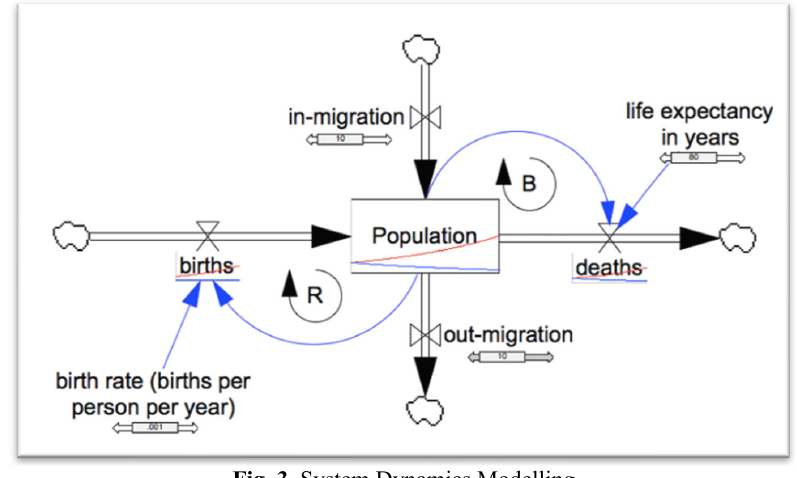
Fig. 3. System Dynamics Modelling Sorce: (Qiu, et al.,